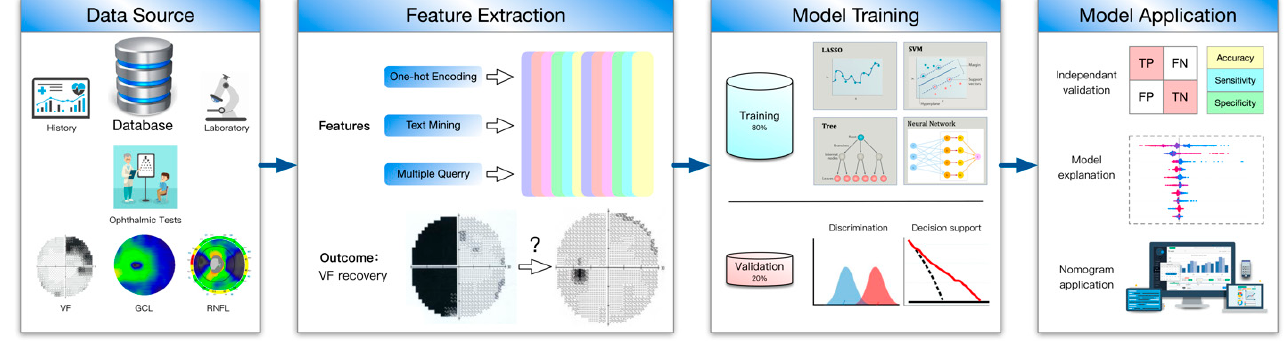
Figure 1. Overall study